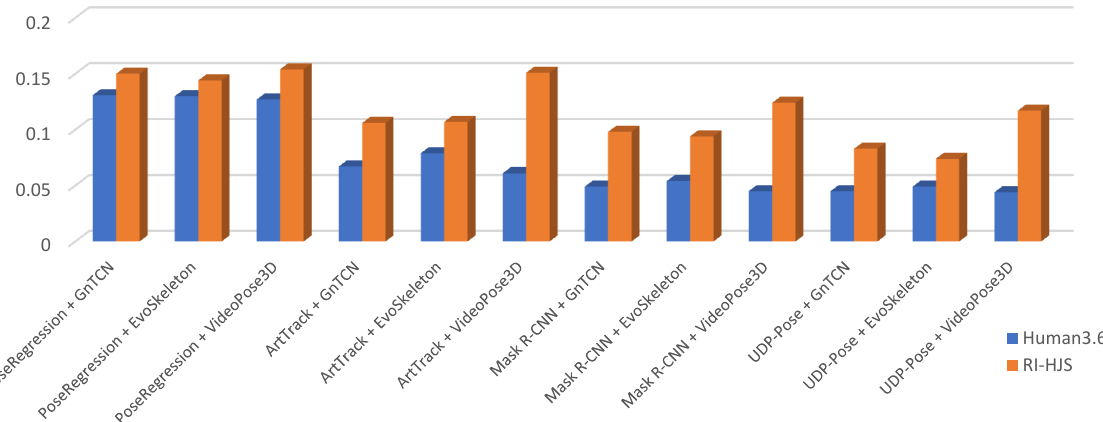
Figure 14. Comparison of the 3D pose estimation model results in terms of PA-MPJPE on Human 3.6M and custom RI-HJS datasets (lower is better). The comparison shows a significant drop in performance on the RI-HJS dataset, which is not surprising given that the models have never seen uncommon poses such as the handball jump-shot from the RI-HJS dataset. Two-step models that use VideoPose3D are more prone to errors due to unseen data, as they have the largest performance drop.